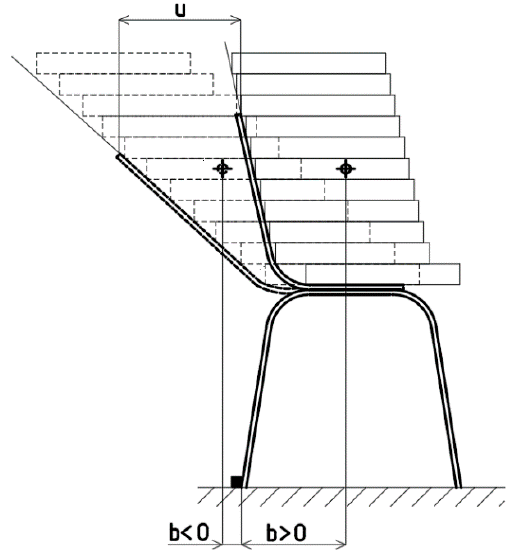
Figure 5. Defining the maximum possible deformation of the flexible chair.